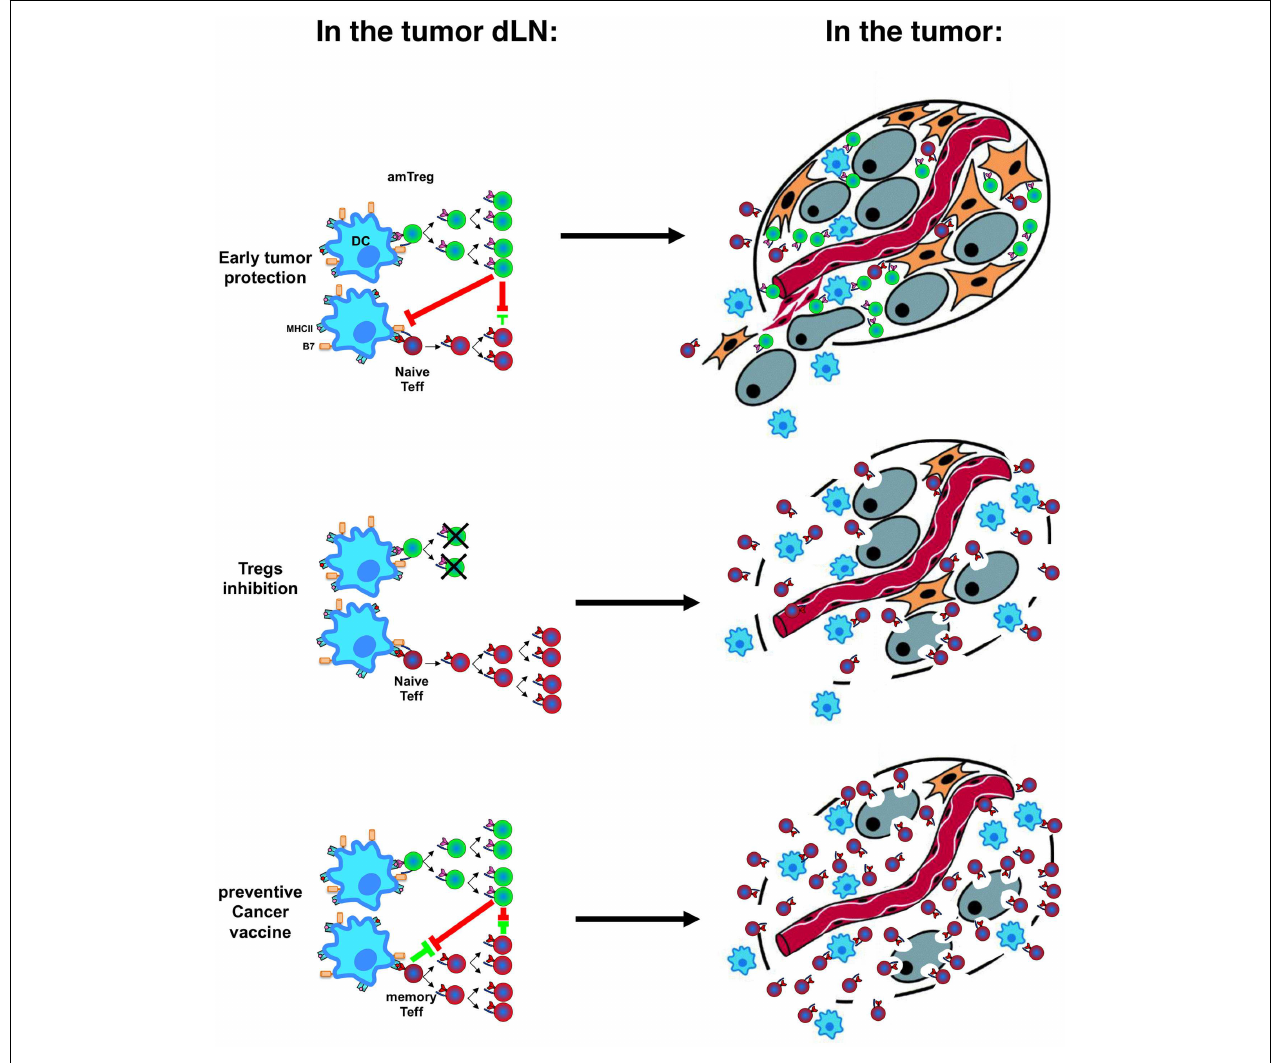
cells (DC, blue) result in the infiltration of the tumor by different cell subsets with different speed and different tumor fate (right, with tumor cells in